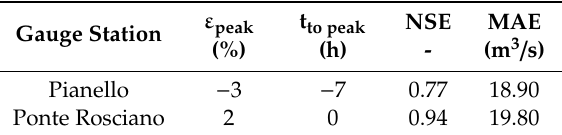
Table 2. Values of the estimation metrics used to calibrate the hydrological model: error between the peak values of the observed and simulated discharge ( ε peak ), the time to peak (t to peak ), the Nash Sutcliff Efficiency index (NSE) and the Mean Absolute Error (MAE) at the two gauging stations of Pianello and Ponte Rosciano.